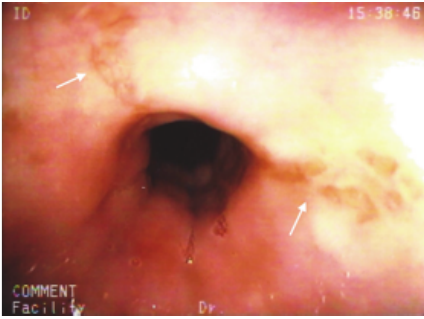
Figure 1: Stellate erosions in the